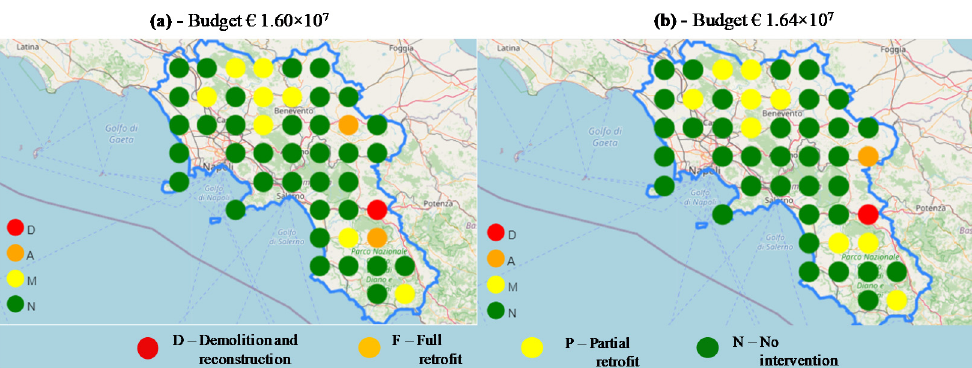
Figure 12. Map of the decision strategies for EUR 1.60 × 10 7 (a) and EUR 1.64 × 10 7 (b).